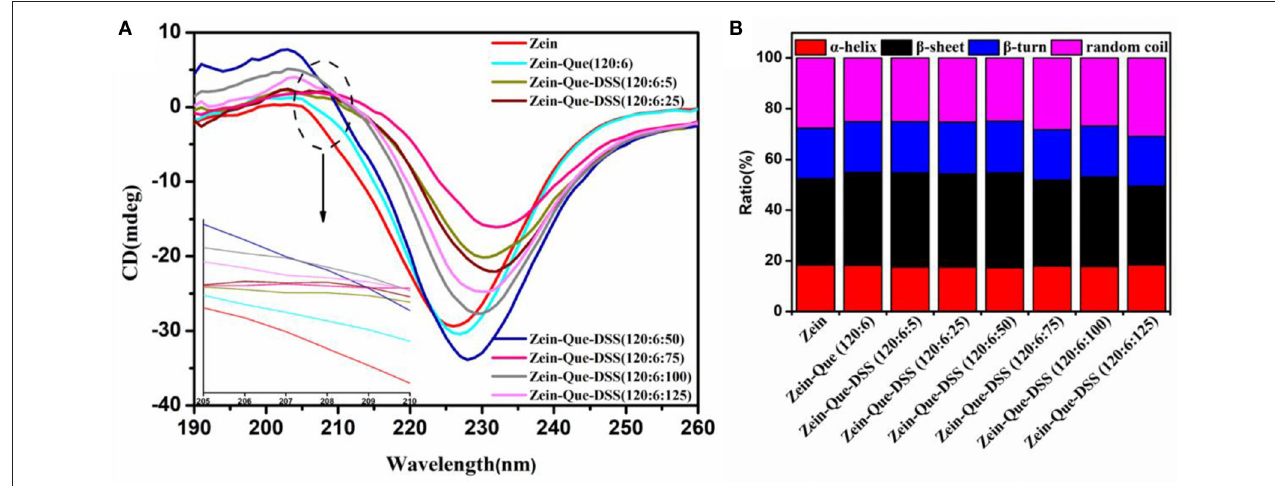
FIGURE 4 | CD spectra (A) and proportion of secondary structures (B) of natural Zein and Zein situated in quercetin-loaded biopolymeric colloidal particles.